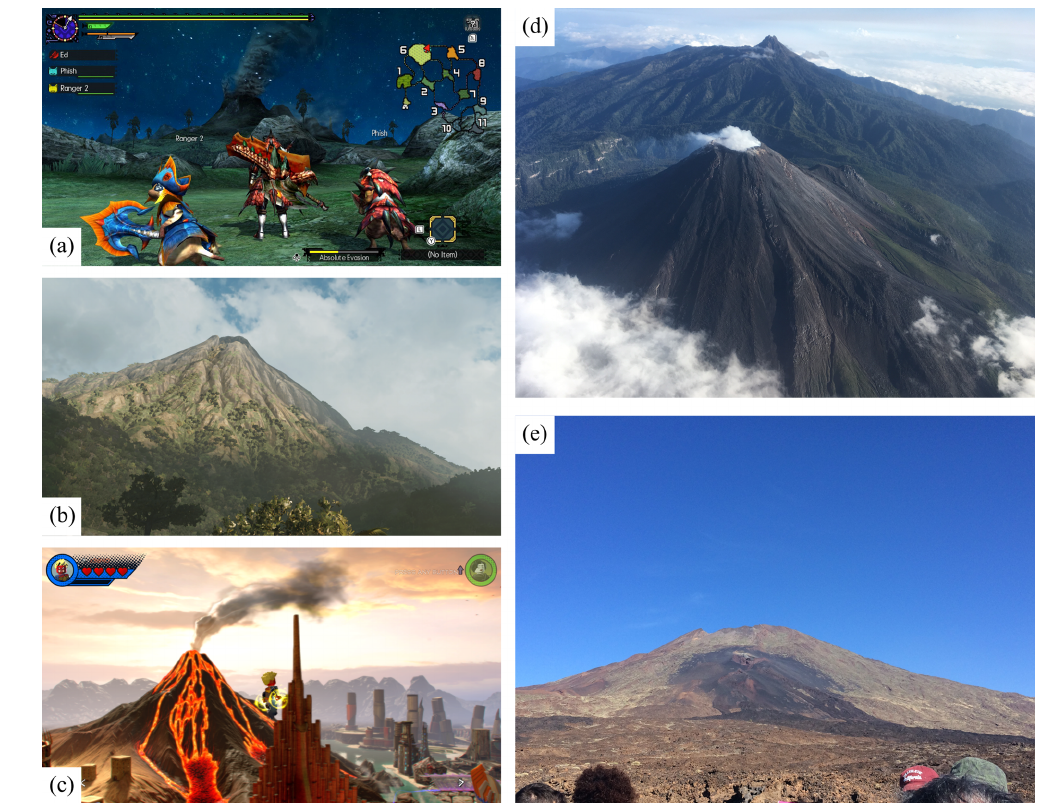
Figure 1. Stratovolcanoes in Monster Hunter: Generations Ultimate © Capcom (2018; a ), The Shadow of the Tomb Raider © Eidos- Montréal (2018; b ) and LEGO Marvel Superheroes 2 © TT Games Ltd (2017; c ); aerial view of the stratovolcanoes Volcán de Colima (foreground) and Nevado de Colima (background) in Colima, Mexico (Edward McGowan, 2018; d ); view of active Las Ca´nadas summit from within Caldera de las Ca´nadas, Tenerife (Edward McGowan, 2016; e